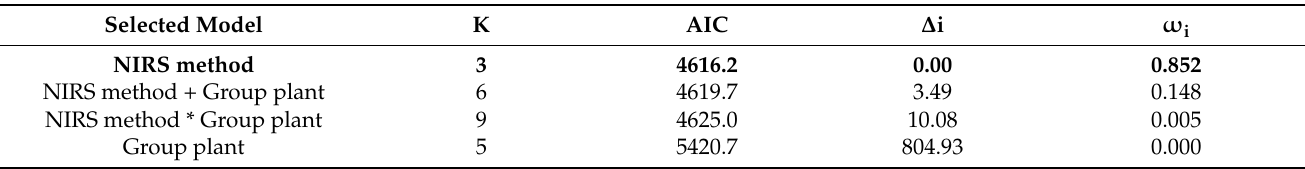
Table 3. Model selection to explore whether the relationships between diet composition of Pyrenean chamois (% presence) assessed by the cuticle microhistological method (reference method) and predicted by near infrared reflectance spectroscopy varies among woody, herbaceous, graminoids and Fabaceae groups.